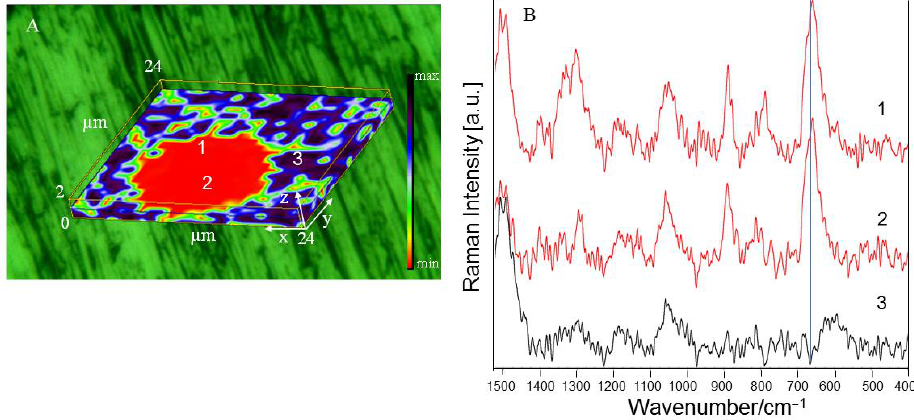
Figure 2. The intensity map of the SERS bands at 660 cm − 1 (Cys (10 − 2 M/PBS, pH = 1.0) ( A ). In situ SERS spectra of Cys (10 − 2 M/PBS) recorded at pH = 1, after 24 h of exposure to the Ti surface in the solution system from points 1, 2, and 3, marked spots in A ( B ).